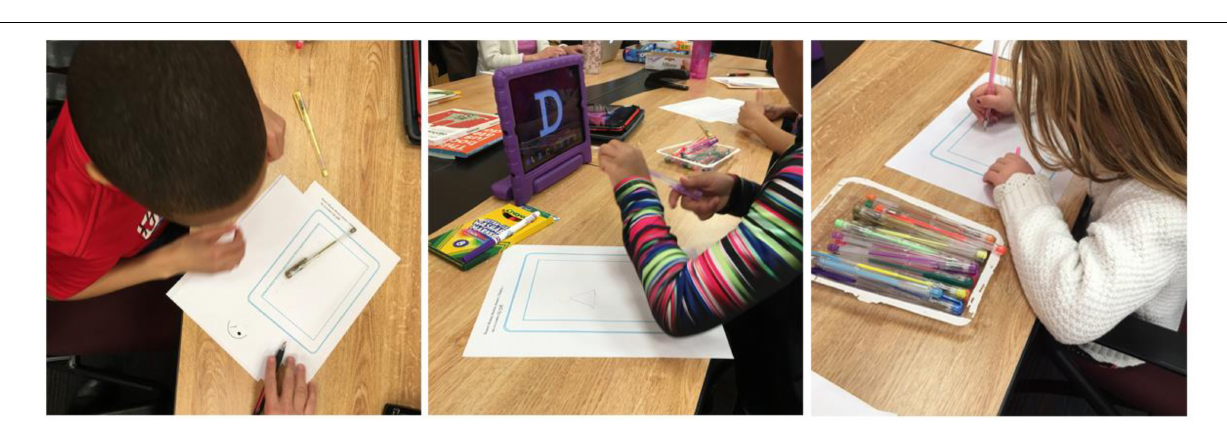
FIGURE 2 | Co-design activity with three